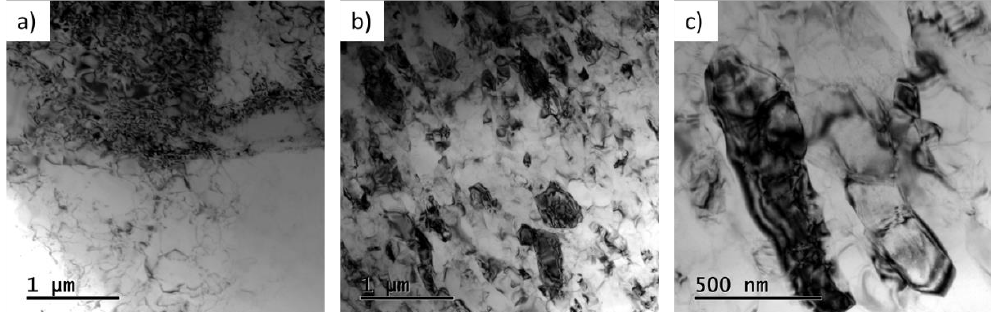
Figure 6. TEM micrographs presenting the microstructure of the sample at individual stages of CSET, ( a ) before extrusion, and ( b,c ) between the two ECAP passes ( b , c ), both RD.